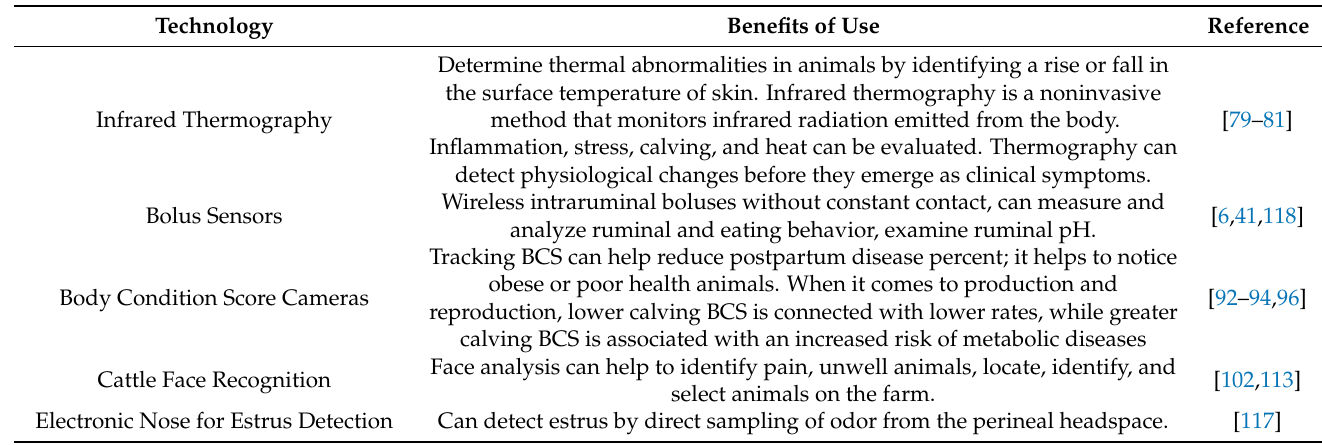
Table 4. Other sensors and their benefits.